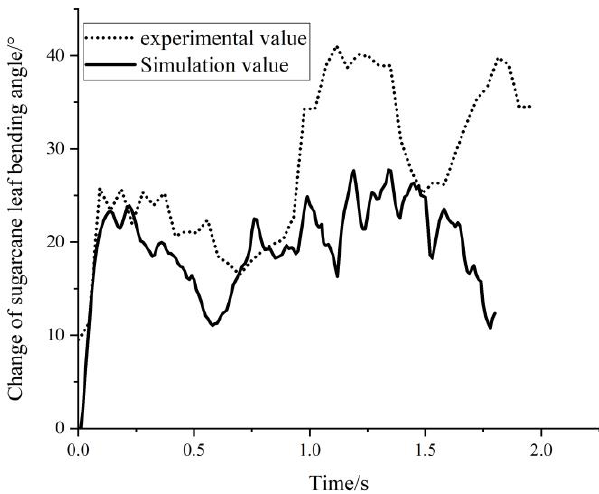
Figure 17. Comparison of experimental and simulated values of bending angle change.